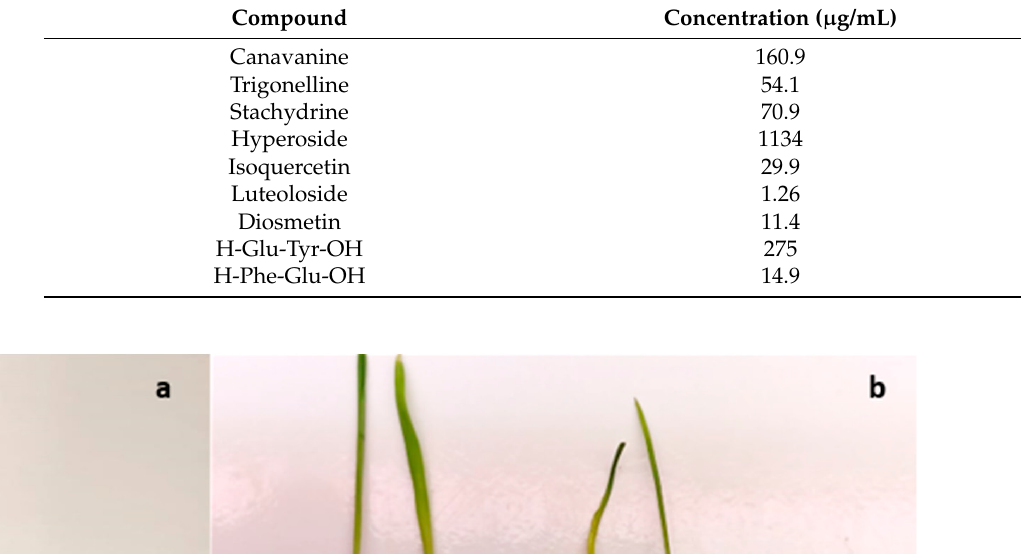
Table 2. The concentration of compounds present in the alfalfa seedling exudates.